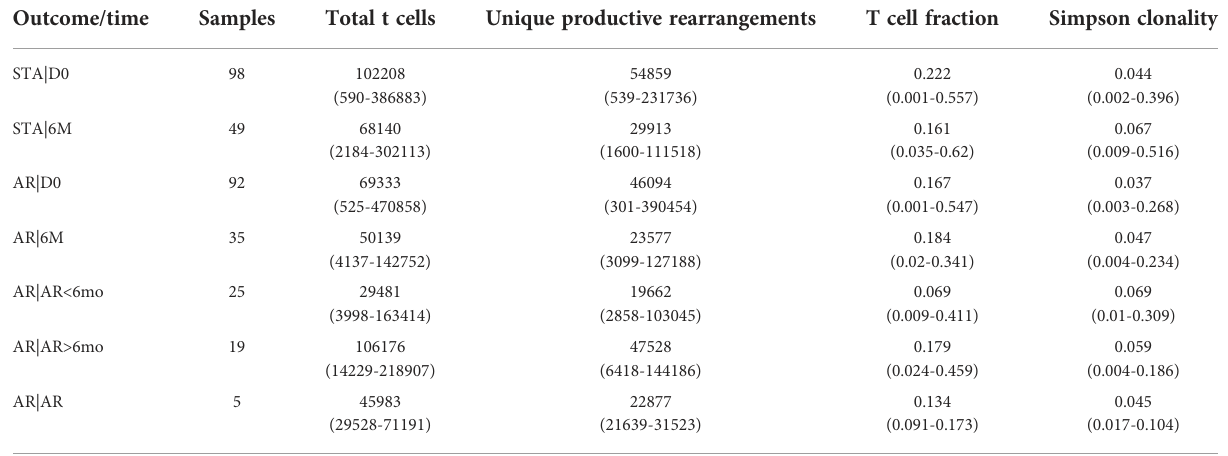
TABLE 2 Sequencing